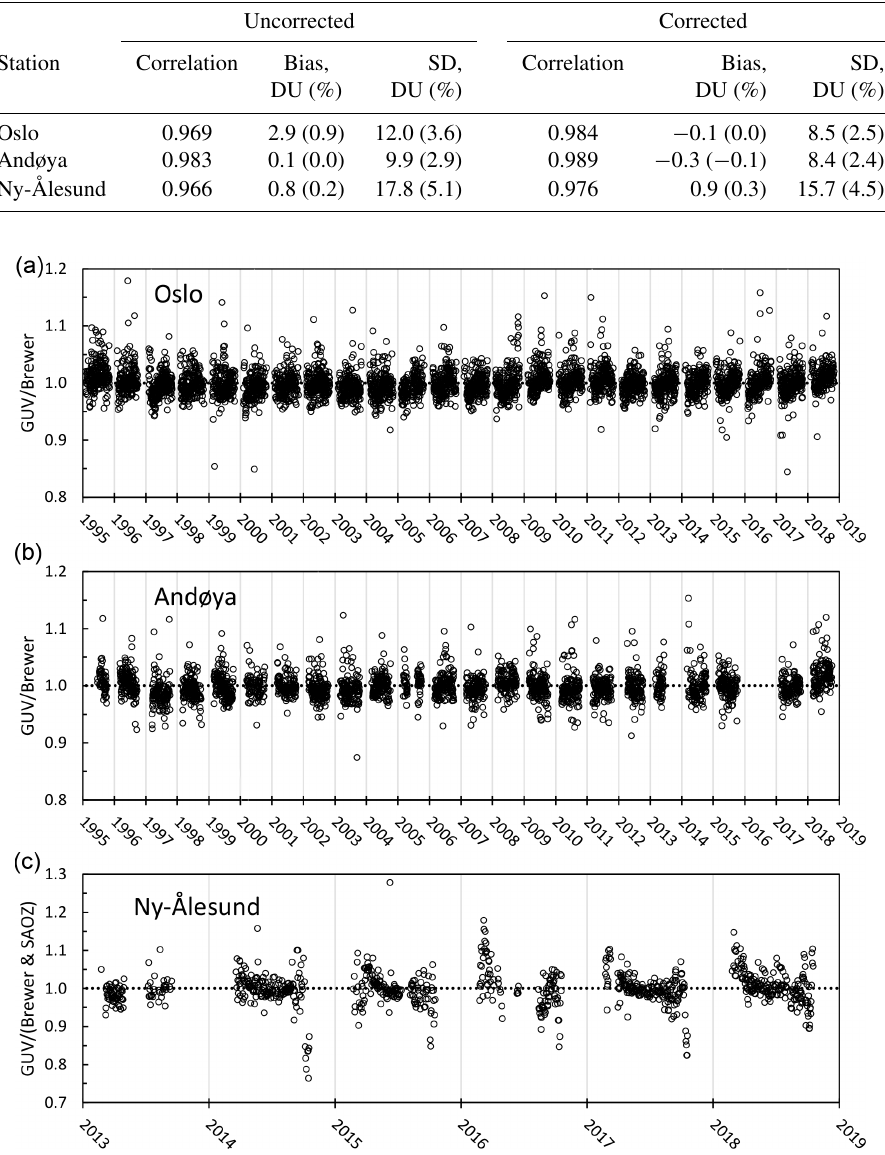
Figure 6. Ratios of GUV / (Brewer and SAOZ) ozone values measured in Oslo (a) , Tromsø/Andøya (b) , and Ny-Ålesund (c) for the GUV corrected data sets. Measurements for all SZA and eCLT values are